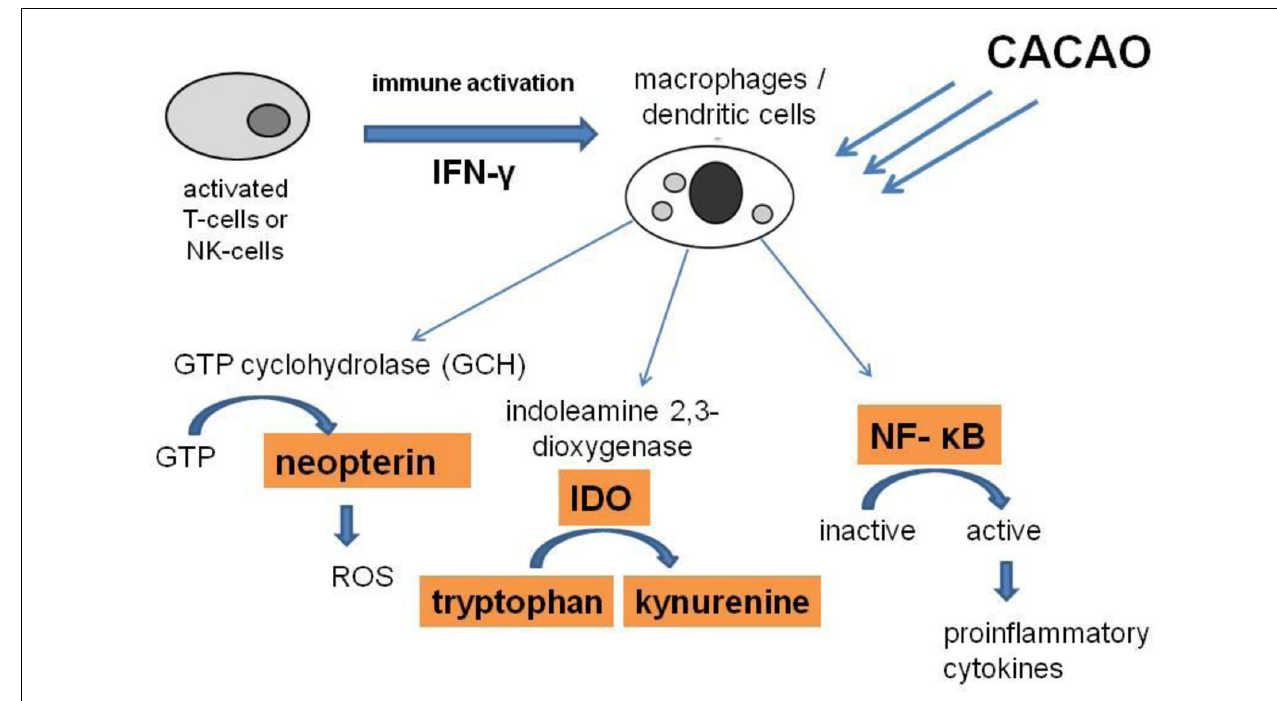
induced to produce neopterin out of GTP. Neopterin plays a major role in the release of reactive oxygen species (ROS) in human macrophages. When oxidative stress is rising to higher levels, transcription factor nuclear factor- κ B (NF- κ B) becomes activated and induces the pro-inflammatory signaling pathways. Cacao, acting as an antioxidant, can influence and counteract against these